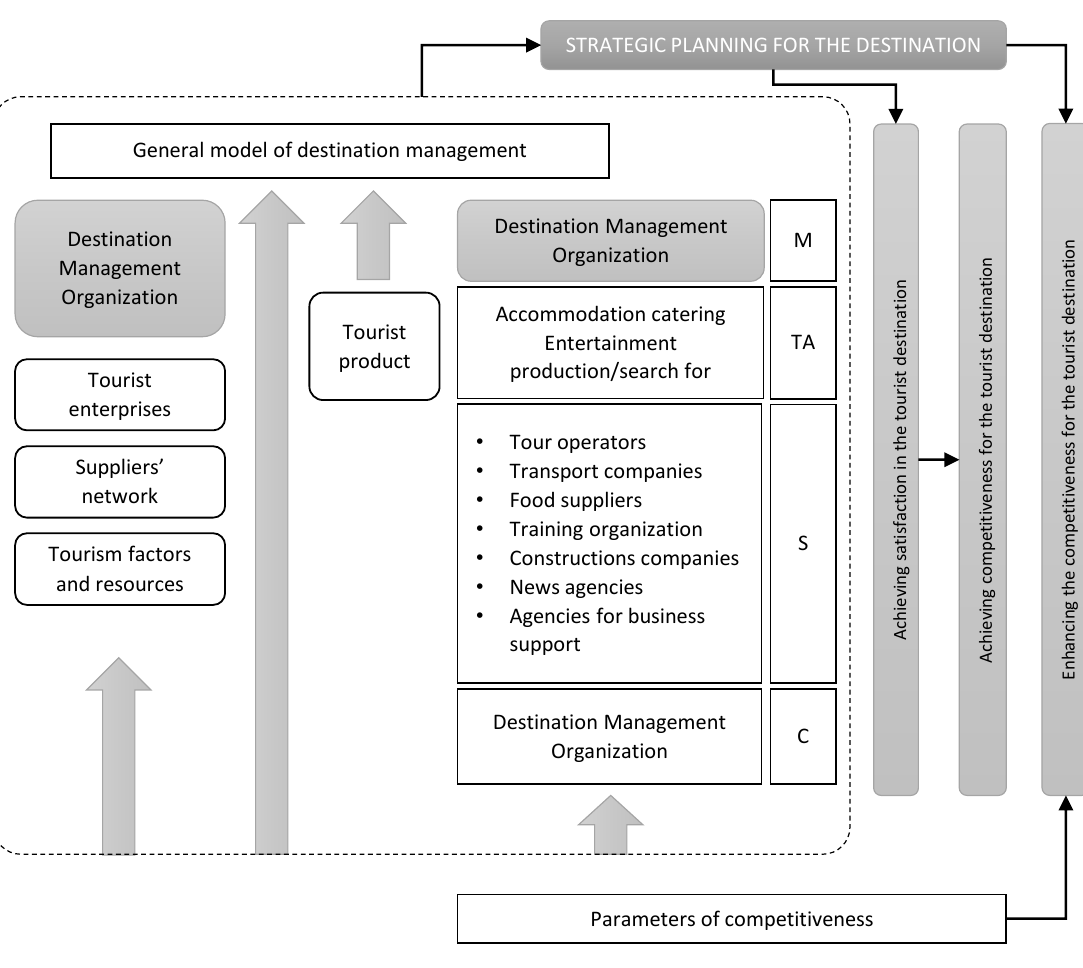
Fig ure 1. Model for increasing the competitiveness of tourist